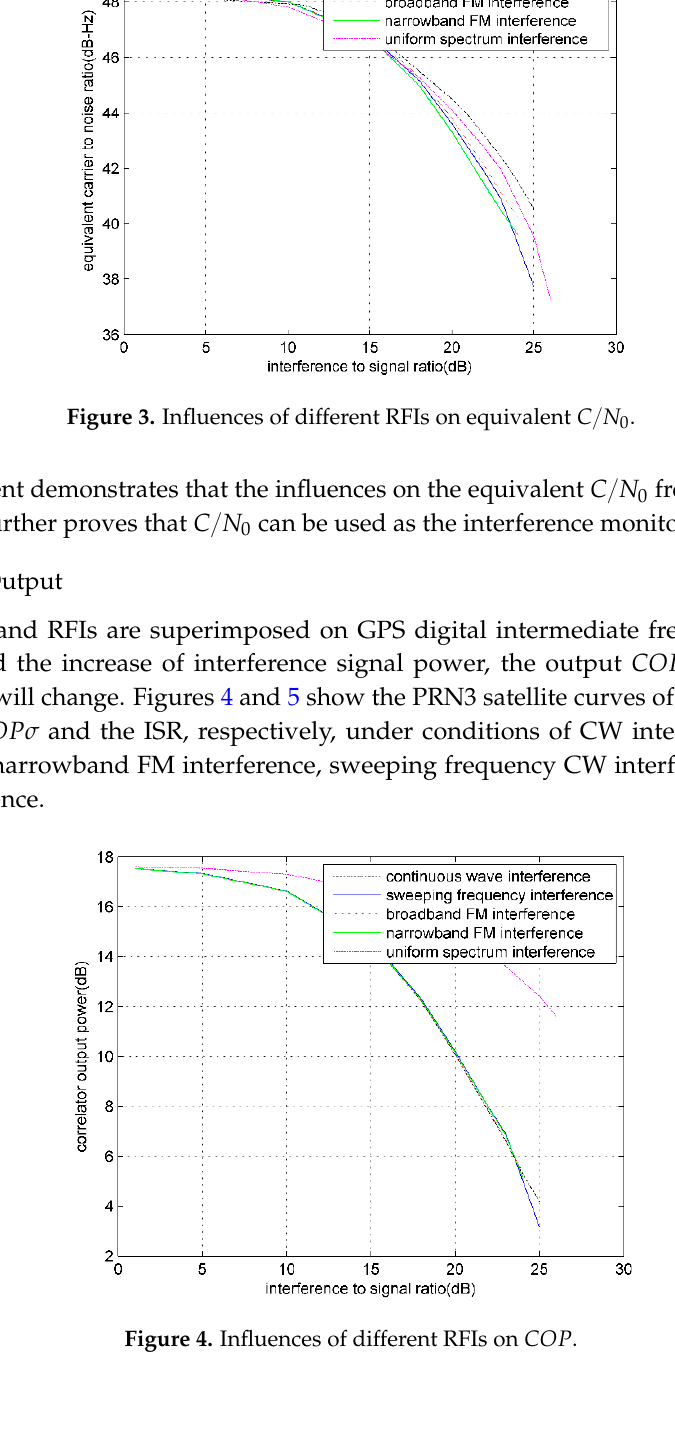
Figure 5. Influences of different RFIs on COP  . In order to better analyze the impact on COP from RFIs, Figure 6 depicts the relation curves of COP  to COP mean ratio under conditions of different RFIs and interference strength. Figure 6. The variation curves of COP  to COP mean ratio under different RFIs.